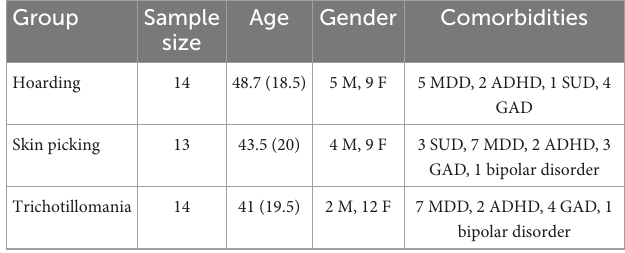
TABLE 1 Descriptive statistics for each group, reporting sample size, age mean and standard deviation, and male/female ratios.